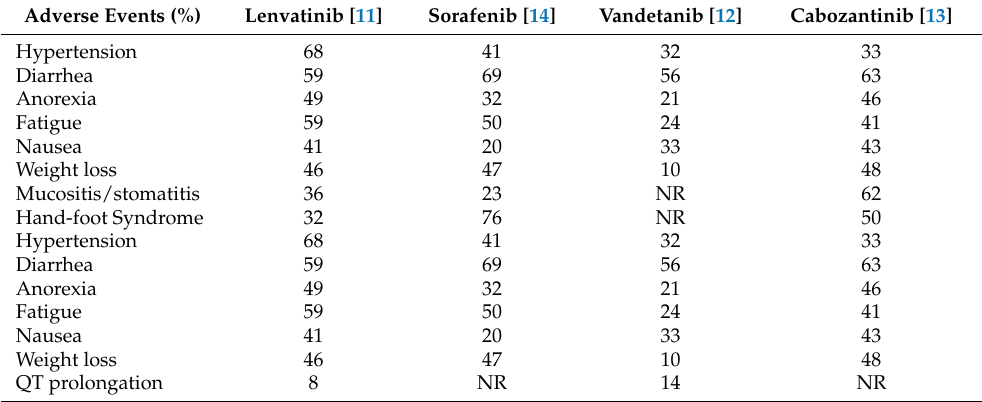
Table 1. Most common side-effects of multikinase inhibitors used in advanced thyroid